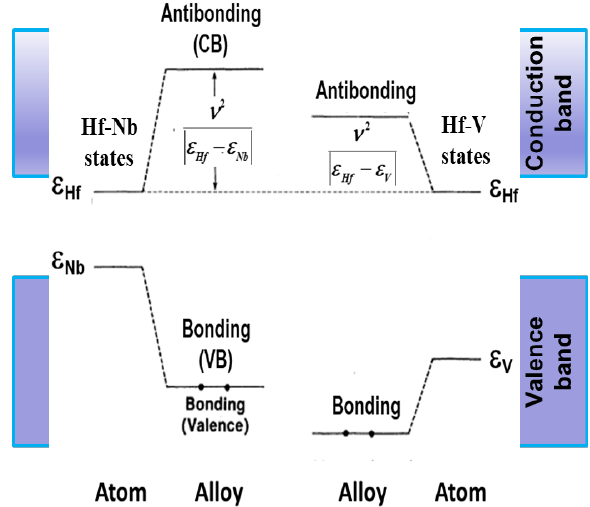
Figure 6. Schematic two-state model to illustrate the difference between the positions of the bonding and antibonding levels relative to conduction band ( CB ) and valence band ( VB ) in V- and Nb-doped HfNiSn compounds. See text for more details.